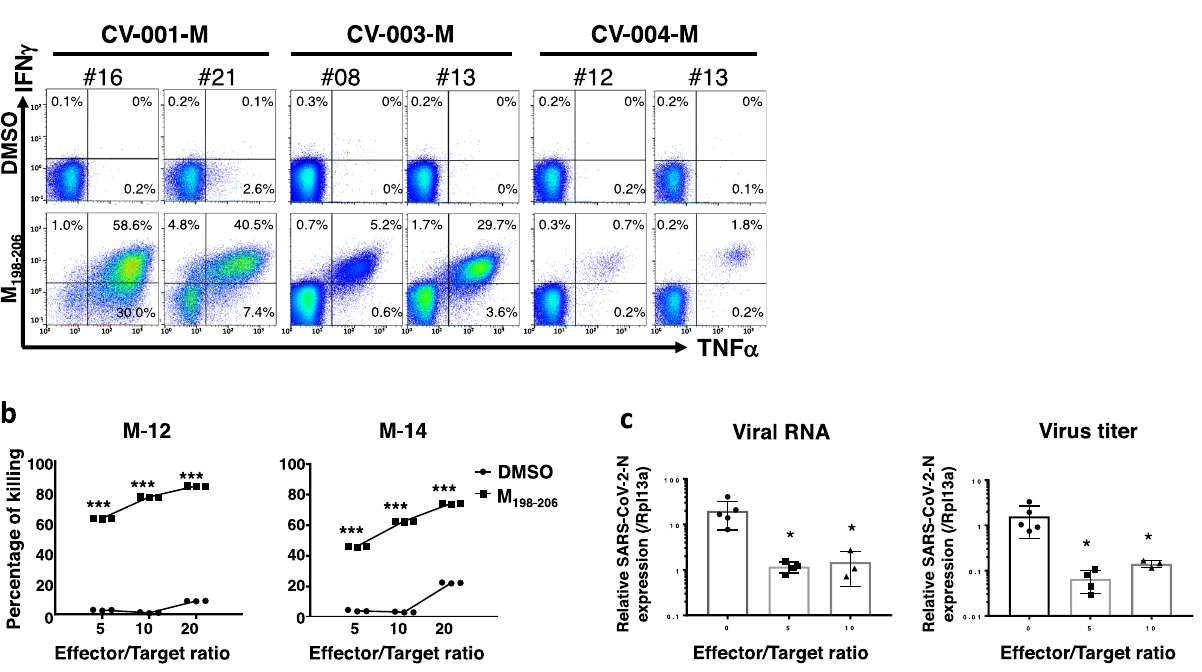
Fig. 3 | Cytotoxic and antiviral activity of M198 – 206-speci fi c CD8+ T cells. a Intracellular cytokine staining of M protein-responding libraries (cell lines) from COVID-19 convalescents. Representative data is shown. b CTL activity of M 198 – 206 speci fi ccelllineswasassessedwithCalcein-labeledairwayepithelialcelllineCalu-3 with (squares) or without (circles) M 198 – 206 peptide. The percentages of killing are shown atdifferent Effector/Target (E/T)ratios. Data represents mean±SD ( n =3 in each group). p values were calculated with two-sided unpaired t test. *** p =3.3×10 − 10 , 4.2×10 − 10 , and 7.1×10 − 11 for M-12; *** p =2.0×10 − 8 , 1.4×10 − 9 , and 1.2×10 − 9 for M-14. c Calu-3 cells were infected with SARS-CoV-2 at an MOI of 0.1. CTLs wereadded to the cells with the indicated effector (CTL)/target (Calu-3)ratio